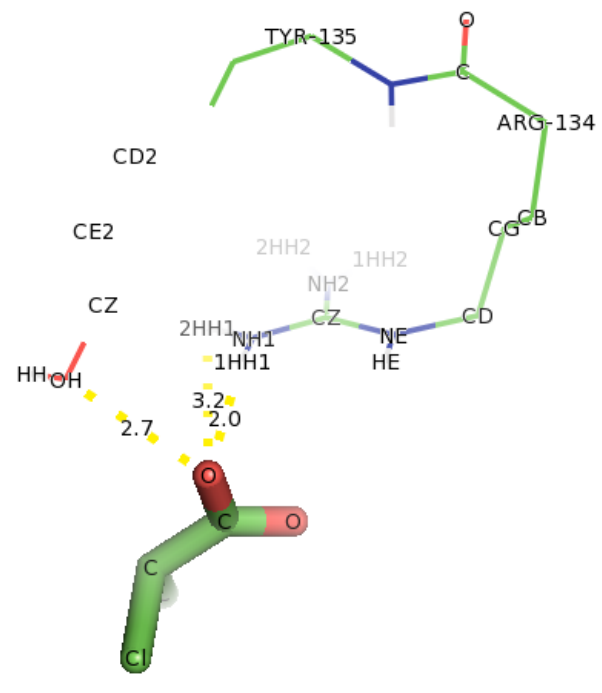
Figure 12. The interacting residues of DehD protein with D -2CP after 2000 ps MD simulation showing hydrogen bonding. Hydrogen bond distances are in Å.